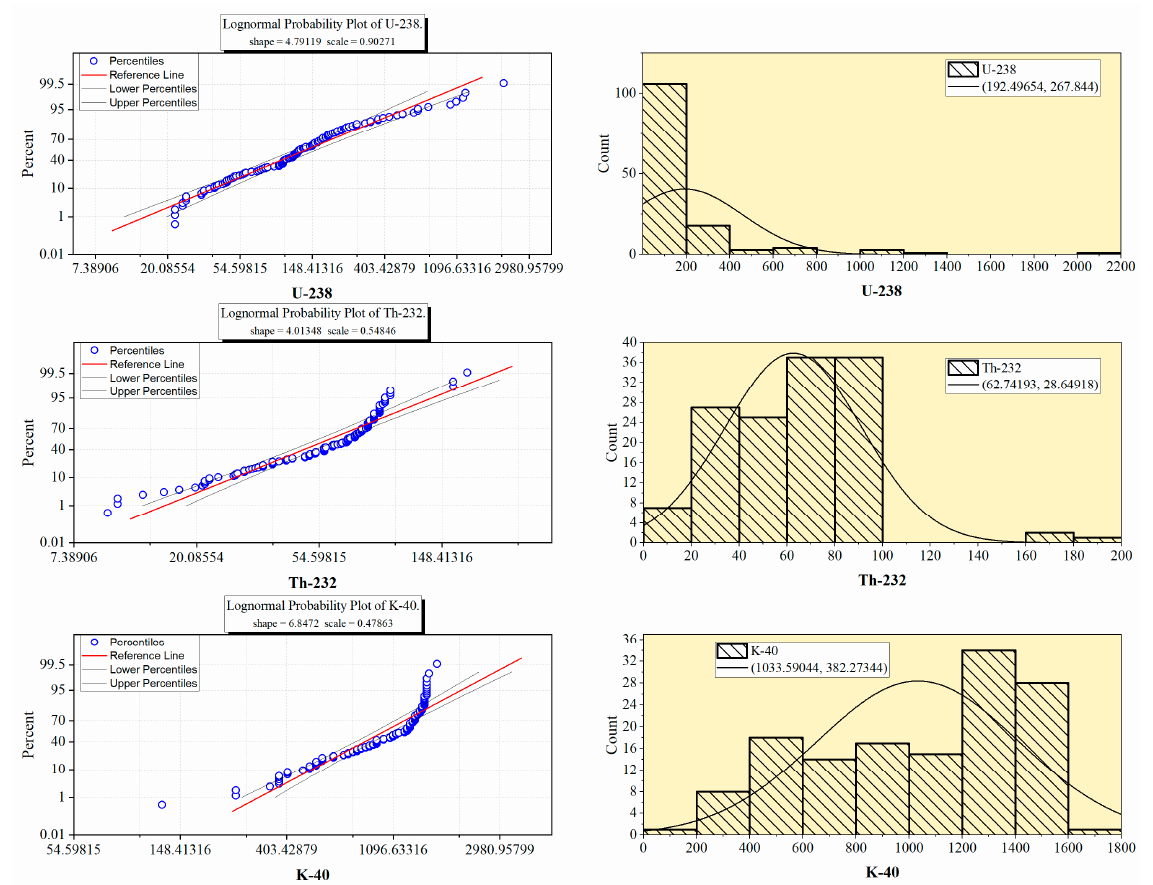
Figure 4. The distribution of 238 U, 232 Th, and 40 K activity concentrations of the muscovite granite rocks in the studied area. Table 3. Comparison of 238 U, 232 Th, and 40 K activity concentrations in the Gabal Qash Amir area with other studies of different countries.